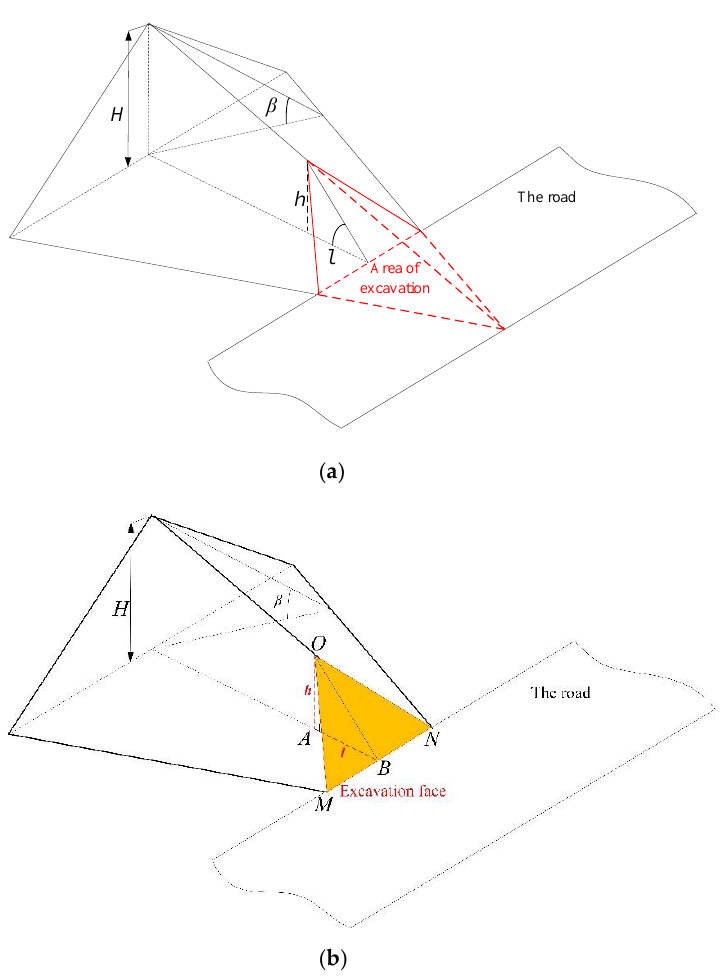
Figure 14. Schematic diagram of ridge slope excavation model, ( a ) pre-excavation; ( b ) post-excavation.